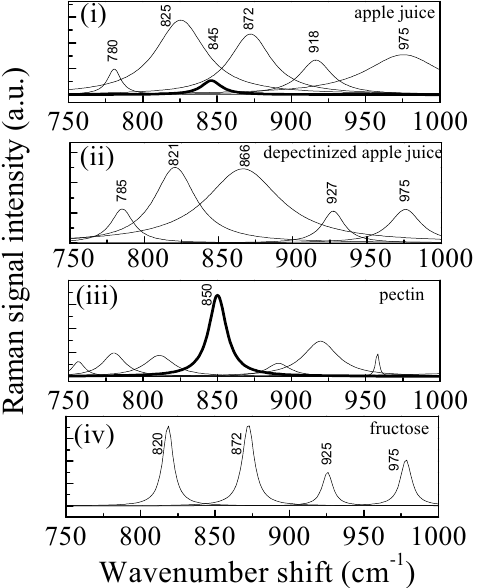
Figure 4. Comparison of Raman spectra of apple juice sample of types A (i) and B (ii) (before and after depectinisation) with those of pectin (sample D) (iii) and fructose (iv) in the 750 - 1000 cm -1 wavenumber shift